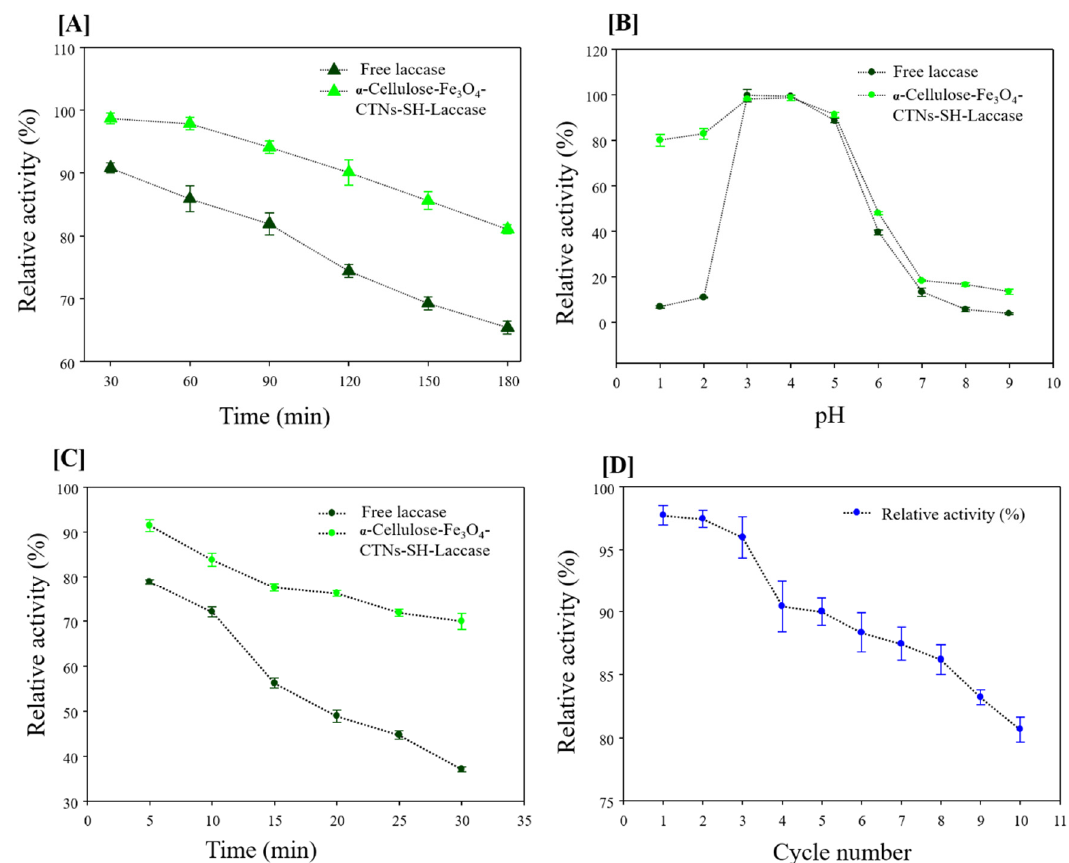
Figure 8. ( A ) Temperature stability of free and α -Cellulose-Fe 3 O 4 -CTNs-SH-Laccase carried out at 60 °C for 180 min time, ( B ) pH stability study of free and α -Cellulose-Fe 3 O 4 -CTNs-SH-Laccase carried out at pH 1–9 for 1 h incubation time, ( C ) storage stability study of free and α -Cellulose-Fe 3 O 4 -CTNs-SH-Laccase carried out at 4 °C and for 30 days, and ( D ) reusability study of the α -Cellulose-Fe 3 O 4 -CTNs-SH-Laccase in 10 cycles.